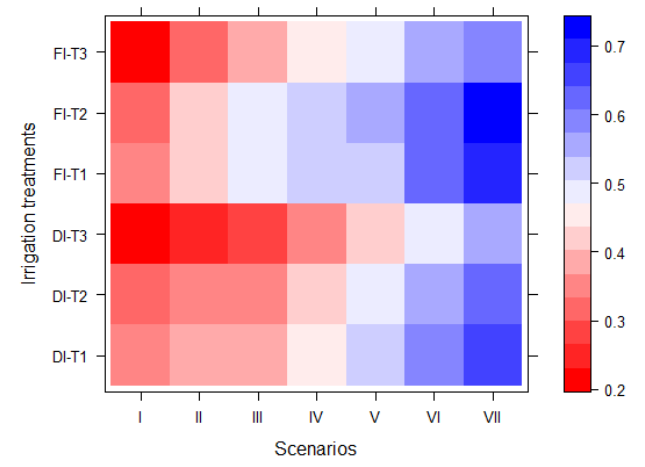
Figure 3. Average values of the integrated index for each treatment (T1, T2, and T3 for control and thresholds of 0.4 and 0.6 crop water stress index for irrigation timing) under drip (DI) and furrow (FI) irrigation for seven scenarios: (I) “highly important” fresh tuber yield (FTY), with other indicators labeled as “unimportant”, (II) “highly important” FTY and “moderately important” production cost (PC), with the other indicators labeled as "unimportant”, (III) “highly important” FTY and PC, with the other indicators labeled as “unimportant”, (IV) “highly important” FTY and PC, “moderately important” total irrigated water (IW), and “unimportant” total C emissions (TE), (V) “unimportant” TE, with the other indicators labeled as “highly important”, (VI) “moderately important” TE, with the other indicators labeled as "highly important”, and (VII) “highly important” for all the indicators.